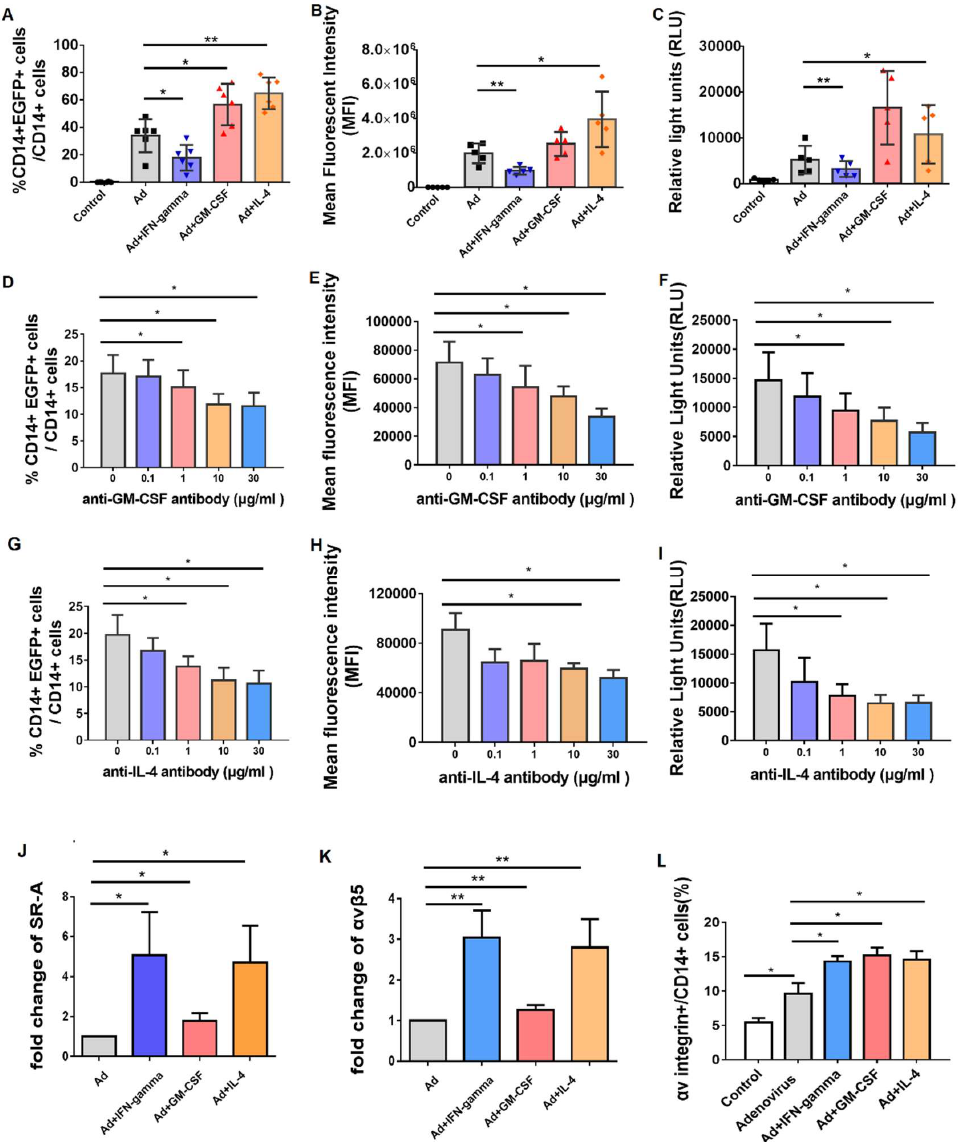
Figure 5. Incubation of GM-CSF and IL-4 promoted the efficacy of adenovirus infection by upregulating SR-A and integrin receptor. 1250 vp/cell of Ad5-EGFP or Ad5-SEAP virus was added into PBMCs with or without recombinant IFN- γ (40 ng/mL), GM-CSF (20 ng/mL) or IL-4 (20 ng/mL) respectively, and the expression of EGFP or SEAP was detected after 48 h. ( A ) The change of percentage of EGFP-positive cells in the different cytokines-treated CD14+ cells ( n = 6). ( B ) The change of expression level of EGFP protein (MFI value) in the different cytokines-treated CD14+ cells ( n = 6). ( C ) The change of RLU (Relative light units) in the different cytokines-treated PBMCs ( n = 6). 1250 vp/cell of Ad5-EGFP or Ad5-SEAP virus was added into PBMCs ( n = 3) with isotype control antibody or anti-human GM-CSF monoclonal antibody (0–30 µ g/mL), and the percentage of EGFP-positive cells ( D ), the expression level of EGFP protein (MFI value) ( E ) and the expression level of SEAP (RLU value) ( F ) were detected after 24 h. 1250 vp/cell of Ad5-EGFP or Ad5-SEAP virus was added into PBMCs ( n = 3) with isotype control antibody or anti-human IL-4 monoclonal antibody (0–30 µ g/mL), and the percentage of EGFP-positive cells ( G ), the expression level of EGFP protein (MFI value) ( H ) and the expression level of SEAP (RLU value) ( I ) were detected after 24 h. Moreover, the expression level of adenovirus-related receptors, including SR-A ( J ) and α V integrin ( K ) was detected by quantitative RT-PCR. The integrin receptor protein on the cell surface was also analyzed by flow cytometer ( L ). The bars represent the standard error. *: p < 0.05, **: p <